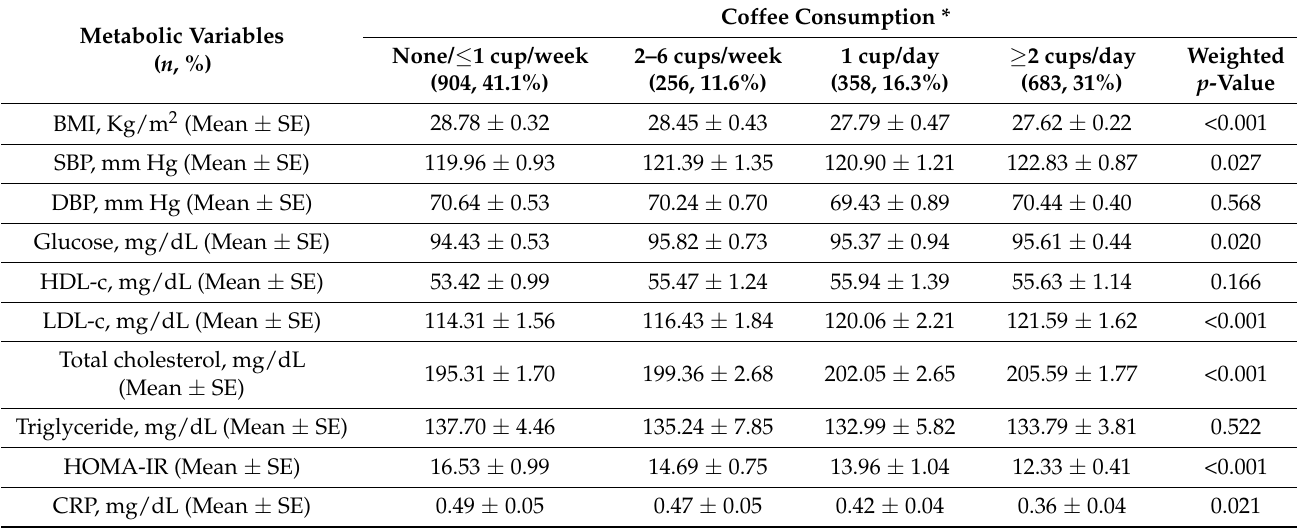
Table 3. Association of metabolic variables, number of metabolic abnormalities, and plasma folate and vitamin B12 levels with coffee